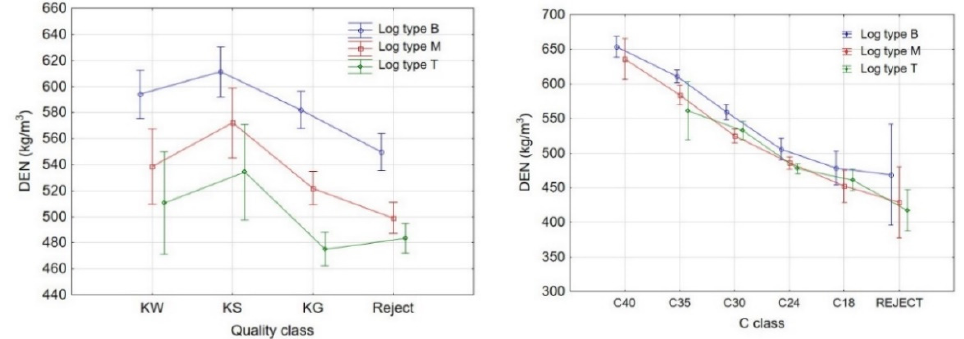
Figure 3. Density distribution in relation to timber quality.